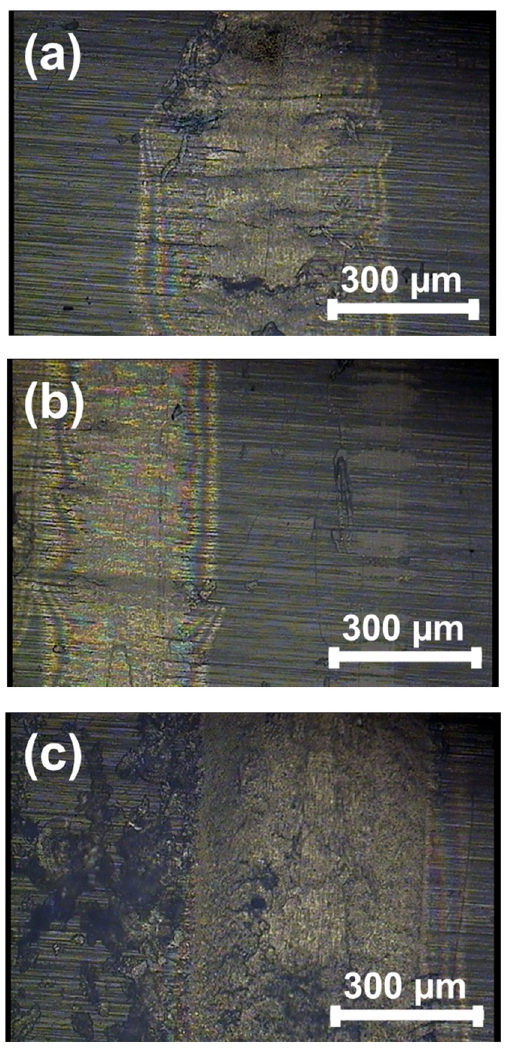
Figure 11: Optical microscopy of wear tracks produced at L = 3 N and ( a ) 0% RH; ( b ) 33% RH; and ( c ) 75% RH on samples made at T = 170°C. Wear tracks are perpendicular to the textured lines of the surface.